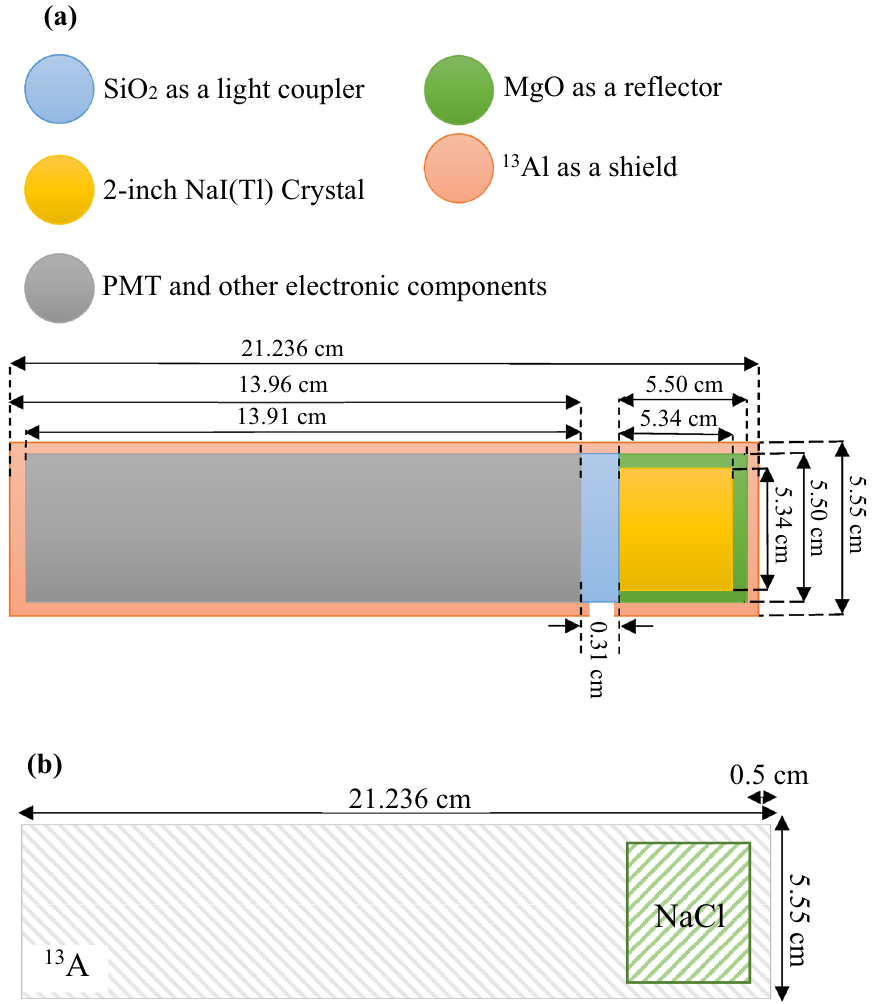
Figure 1. ( a ) Schematic view of the simulated Ø2 ″ × 2 ″ NaI(Tl) scintillation detector. ( b ) Schematic view of the simulated Ø2 ″ × 2 ″ fake detector.